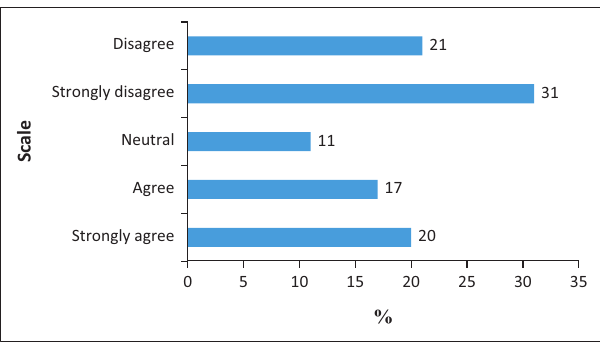
FIGURE 7: Political affiliation used in housing